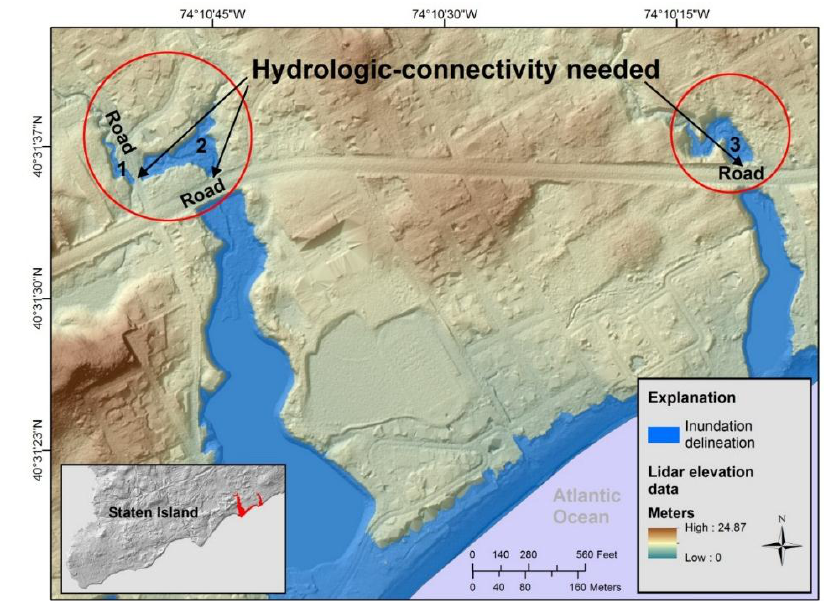
Figure 3. Inundation delineation (blue) that represents lidar elevation values lower than 4.51 m overlain on a high-resolution lidar elevation shaded relief. The roads inside the red circles should be hydrologically-enforced to achieve hydrologic connectivity between the inland inundation analysis. This is what the coastal inundation would look like if the roads were hydrologically-enforced.